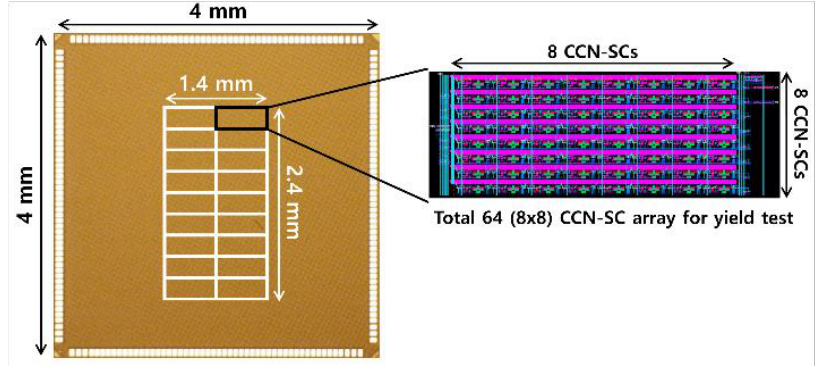
Figure 4. Die image of the test chip implemented using 65 nm CMOS technology.